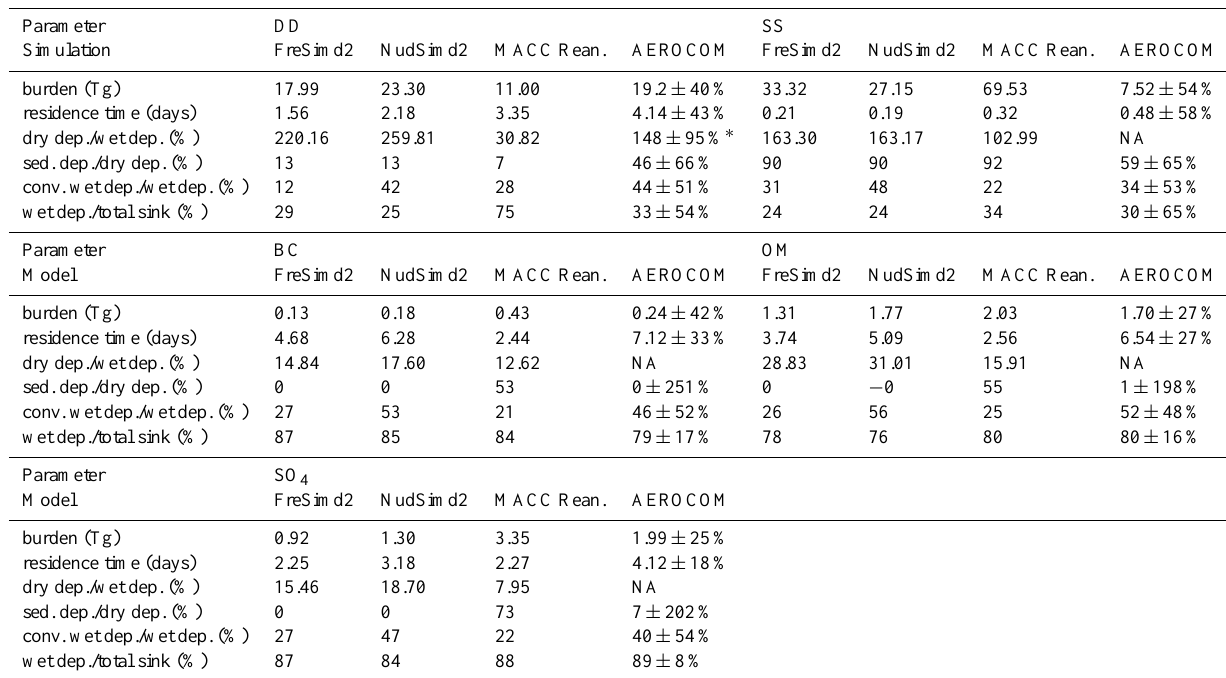
Table 4. Burden, residence time and ratios for various sinks from the FreSimd2 simulation (mean over the 10 repeated 2004 years), the NudSimd2 simulation (year 2004), the MACC Reanalysis (2003–2012 mean), and the AEROCOM models reported in Textor et al. (2006) (mean ± σ , see Table 10).